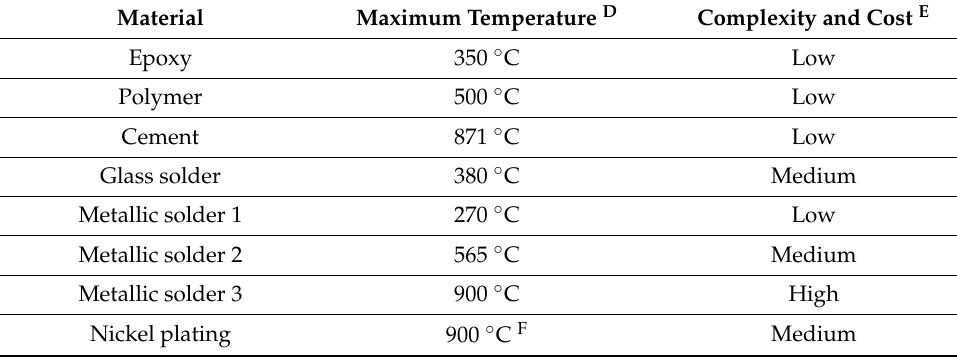
Table 2. Comparison of materials/techniques. Material Maximum Temperature D Complexity and Cost E Epoxy 350 ◦ C Low